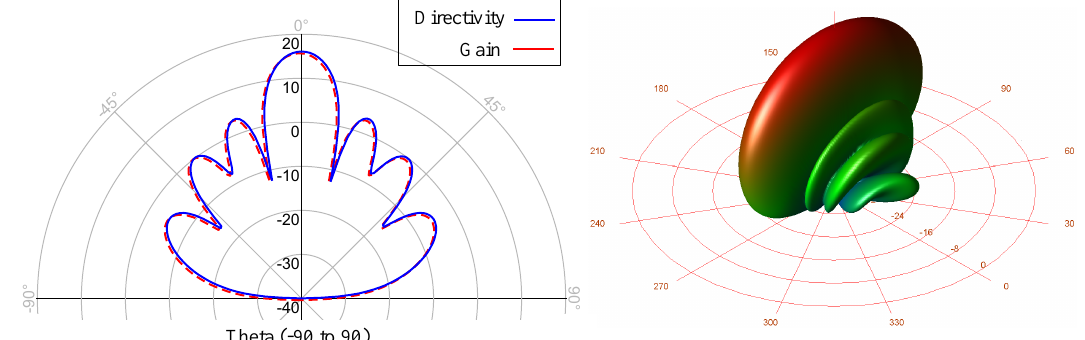
Figure 13. Simulated 3D radiation pattern of the antenna array at 77GHz.